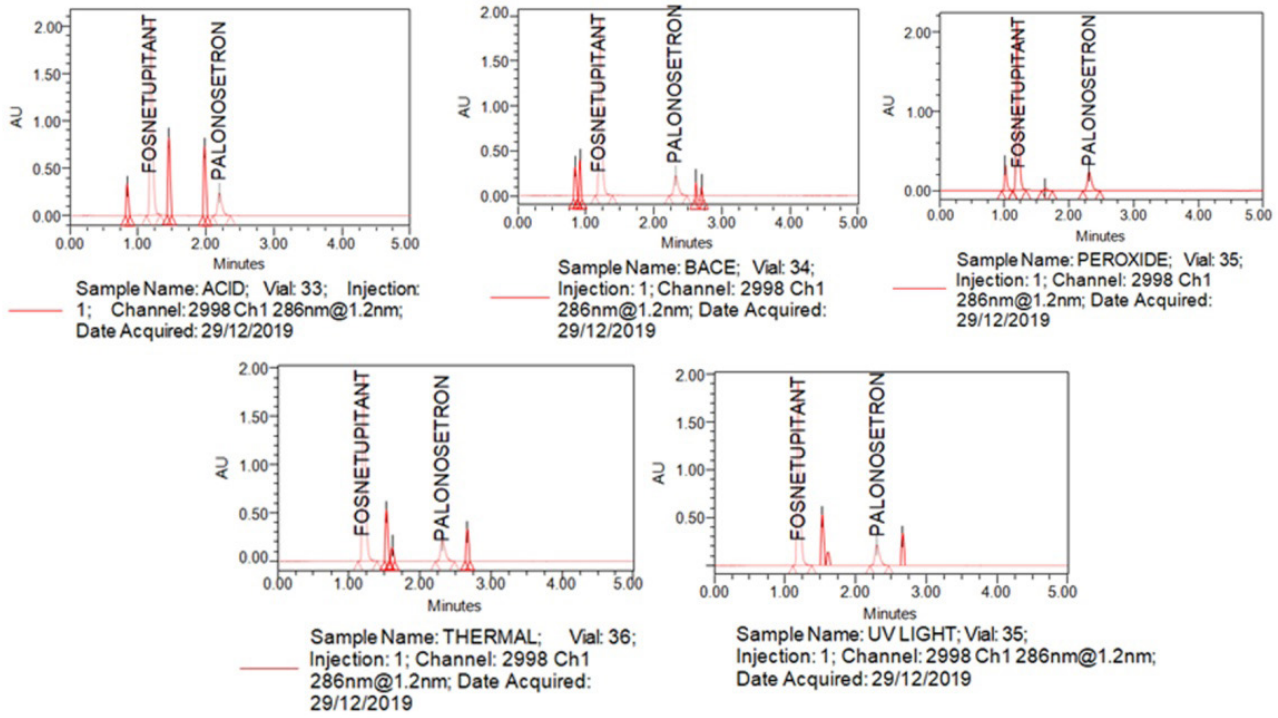
FIGURE 4 - Chromatograms of forced degradation studies.